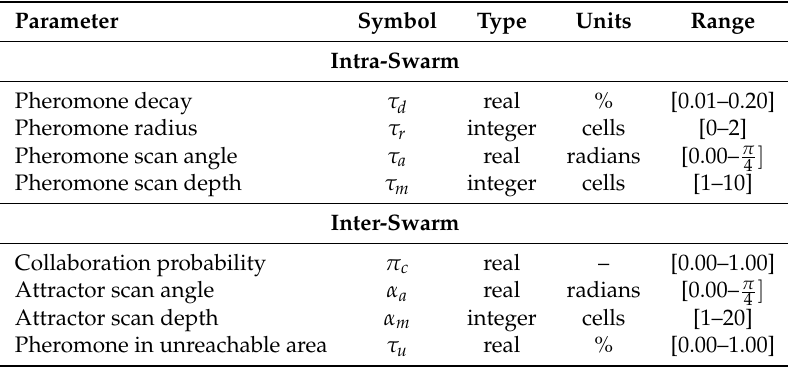
Table 2. Parameters of ABISS to be